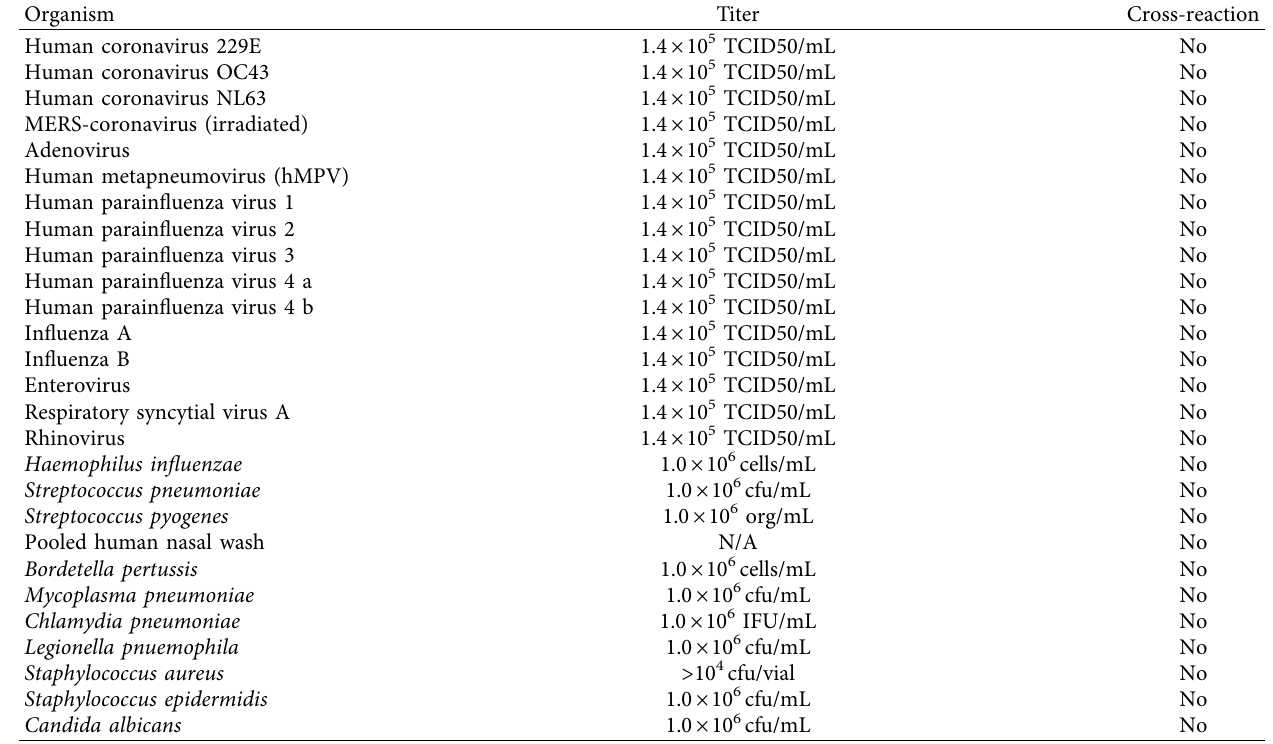
Table 4: Cross-reactivity